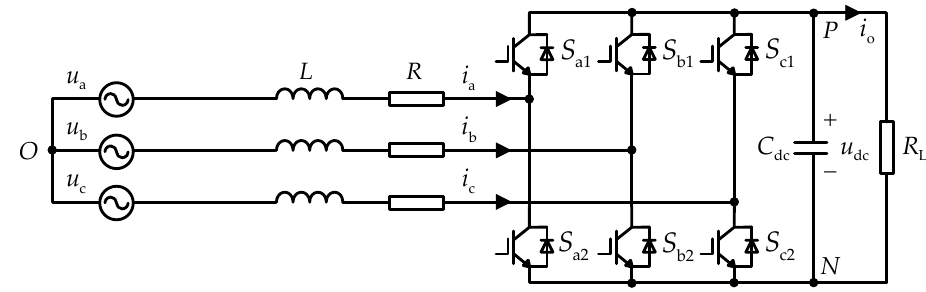
Figure 1. Structure of three-phase voltage-source pulse width modulation (PWM) converter.